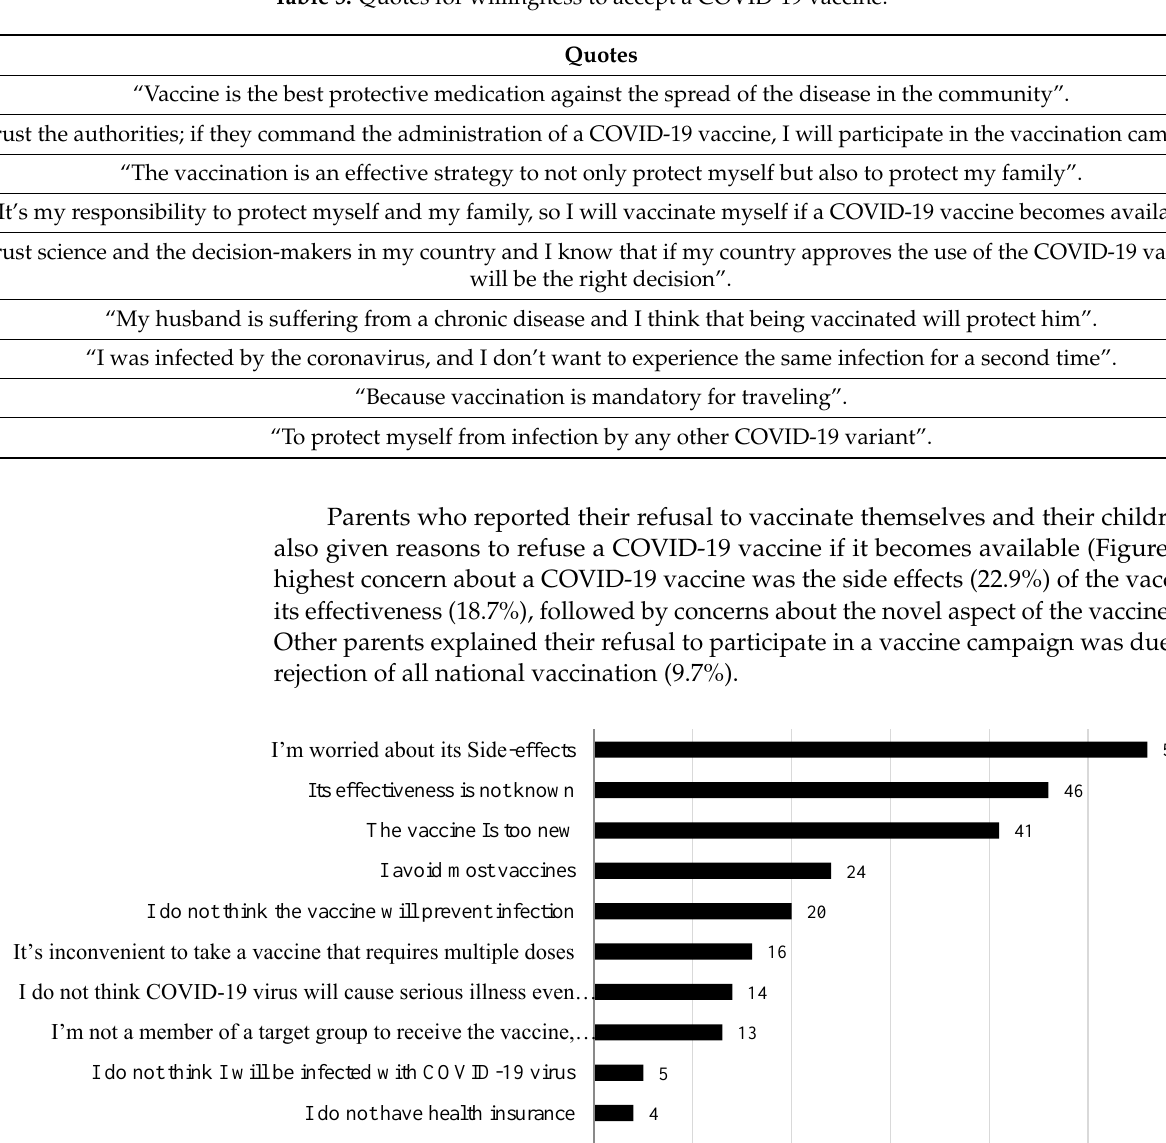
Table 5. Quotes for willingness to accept a COVID-19 vaccine.